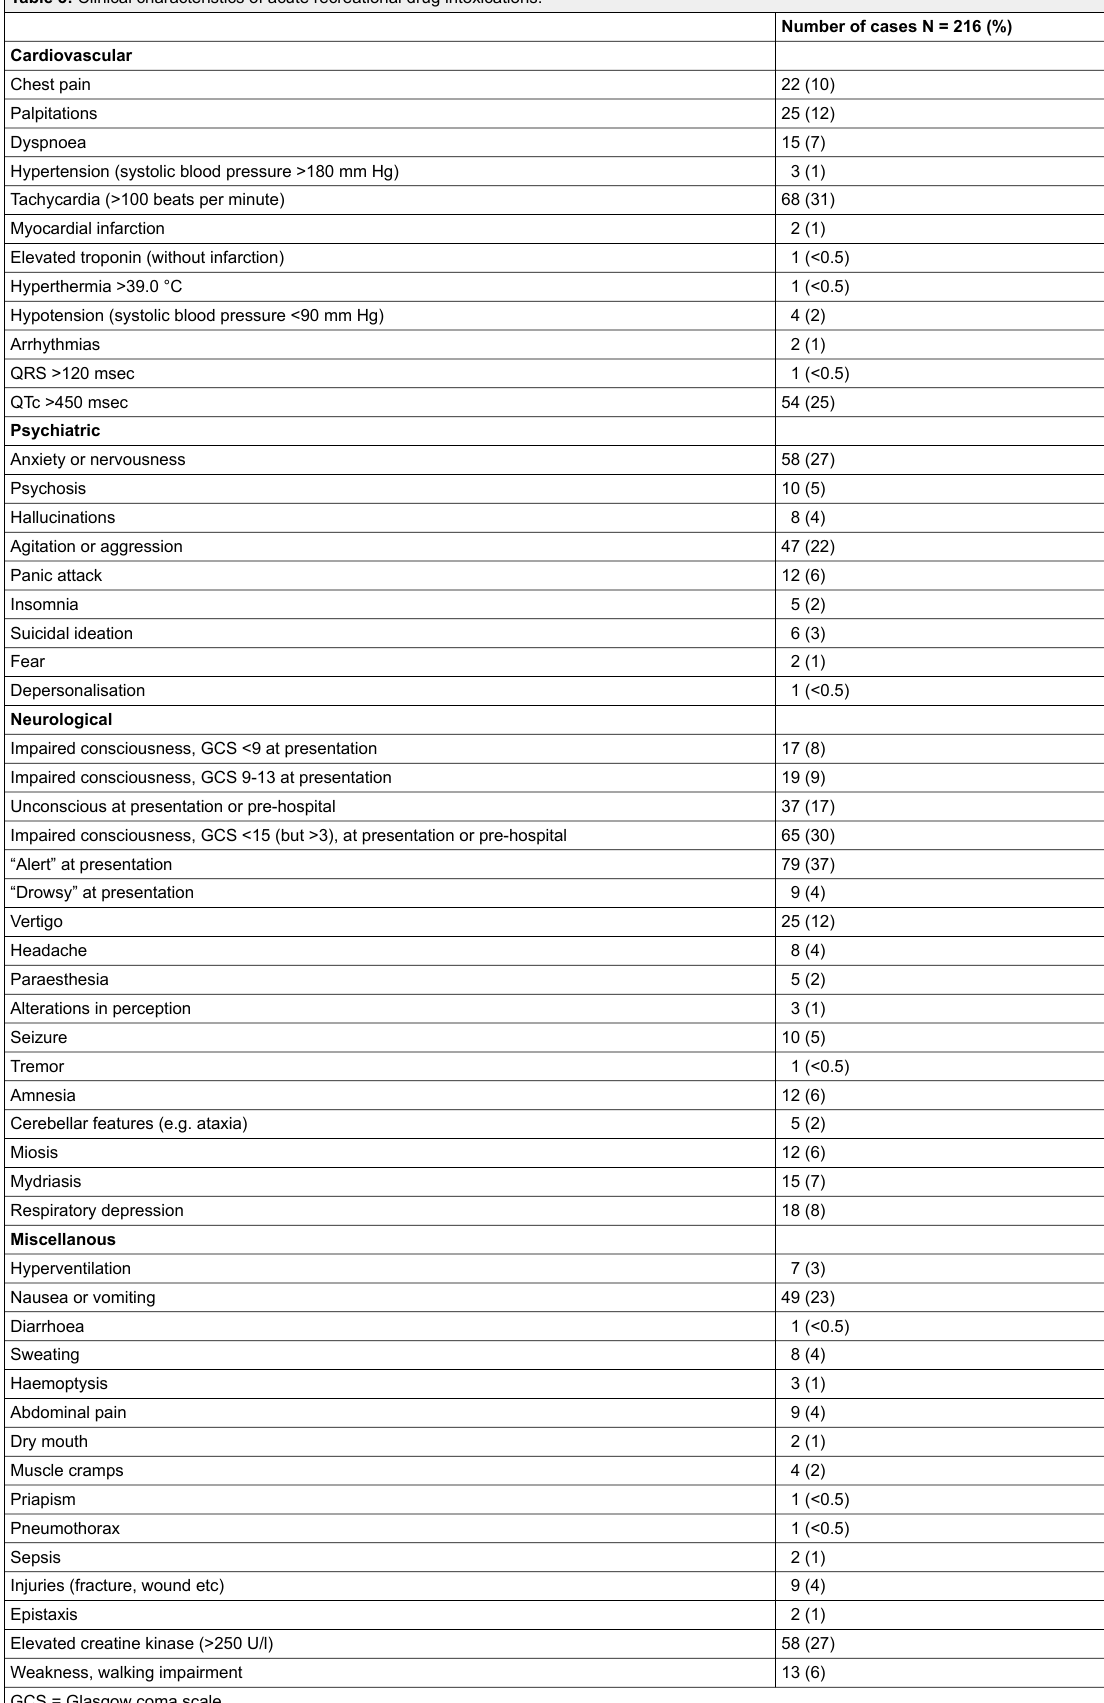
Table 3: Clinical characteristics of acute recreational drug